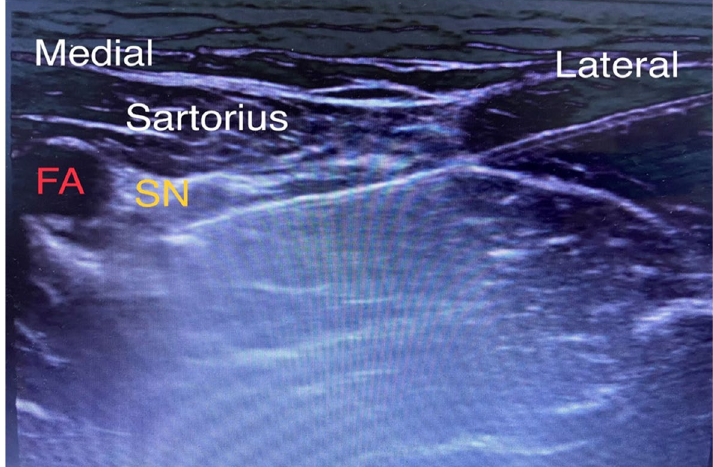
Fig. 2 Spread of local anaesthetic before catheter advancement in the adductor canal. Femoral Artery (FA), Saphenous Nerve